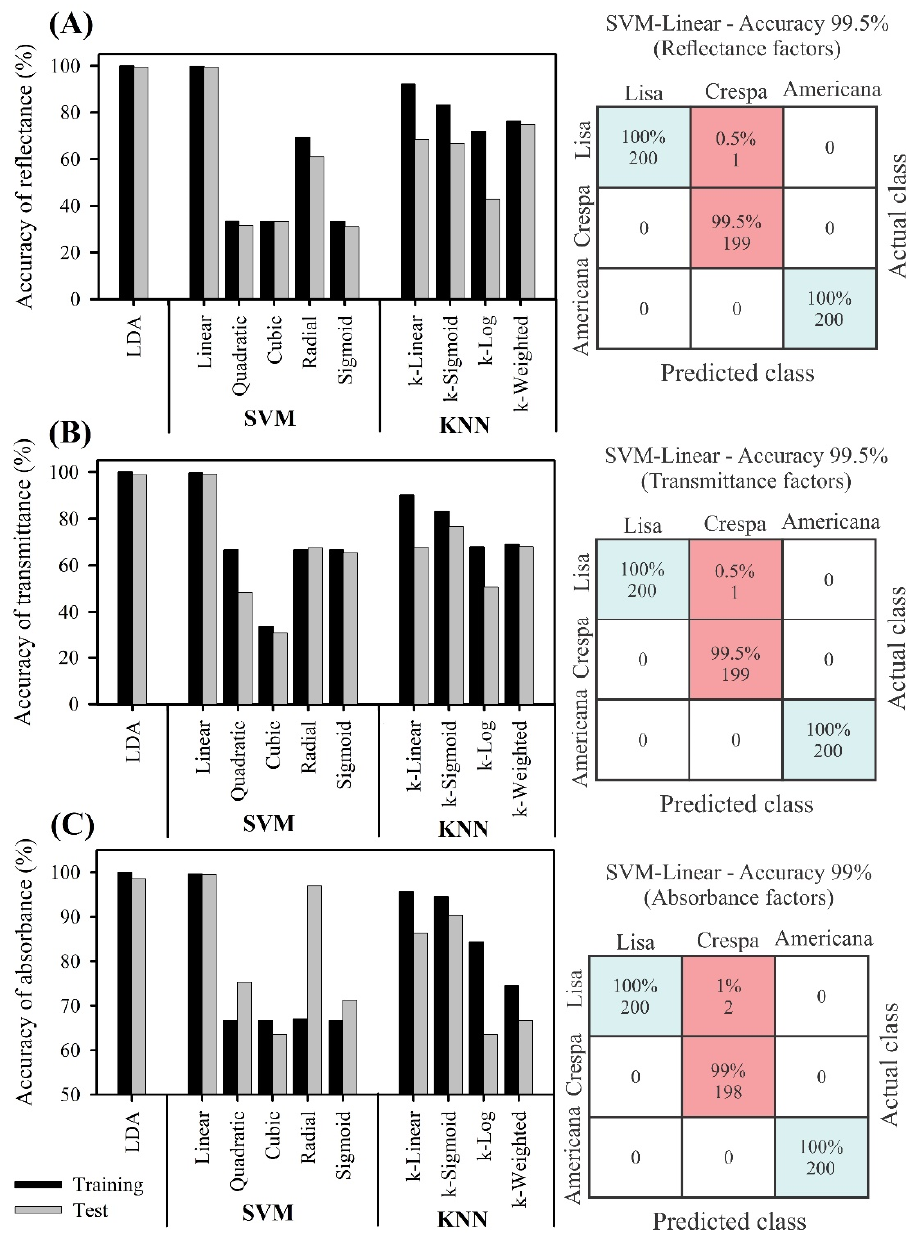
Figure 8. Overall accuracy of machine learning algorithms (linear discriminant analysis (LDA), support vector machine (SVM), k-nearest neighbour (KNN)) based on hyperspectral (400–2400 nm) analysis. First three PCA datasets were selected from training and testing to create a confusion matrix for machine learning algorithm with higher overall accuracy. ( A ) Reflectance, ( B ) transmittance, ( C ) absorbance. Blue box indicates higher accuracy/precision (accept), and red box indicates lowest accuracy/precision (error). Total of 450 training samples and 150 test samples (n = 600).